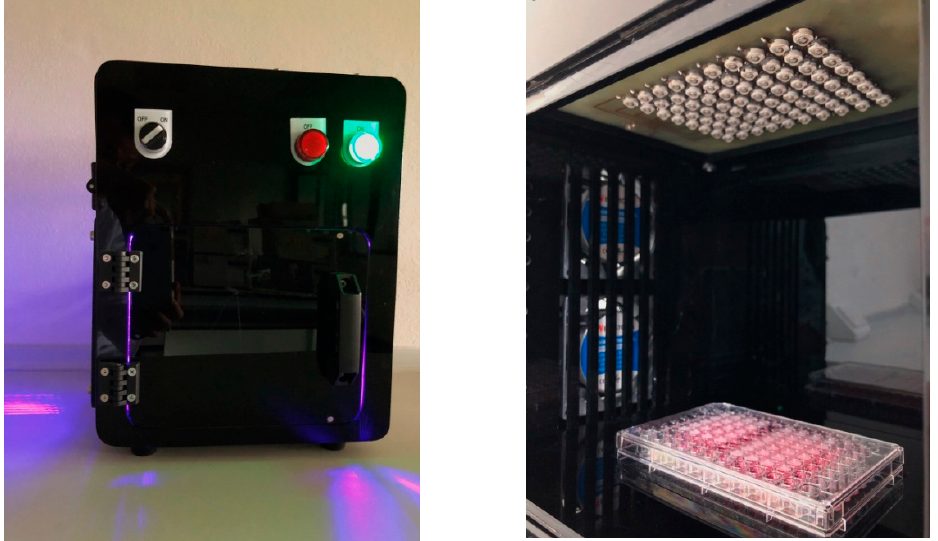
Figure 5. Photograph of the illumination device (left) and the 10 × 8 blue LED array (right).